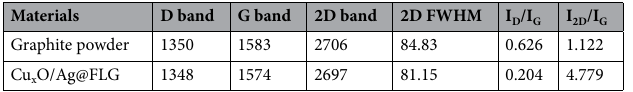
Table 1. The Raman fitting data of graphite powder and Cu x O/Ag@FLG.